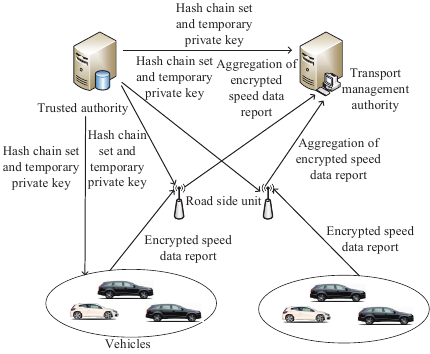
Figure 8. The architecture of the secure and autonomous analysis mechanism for traffic movement.